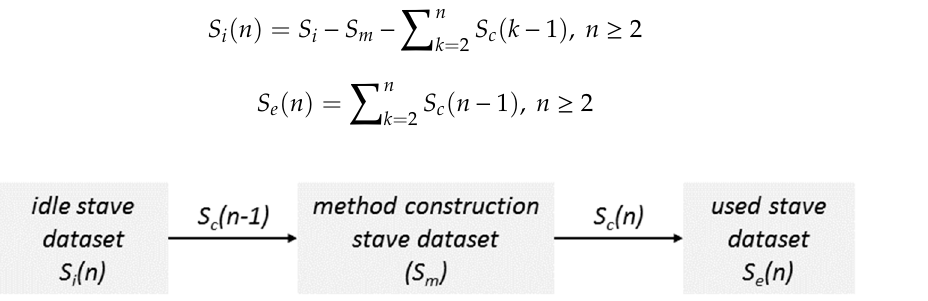
Figure 6. Stave datasets that are considered in the proposed construction methods.